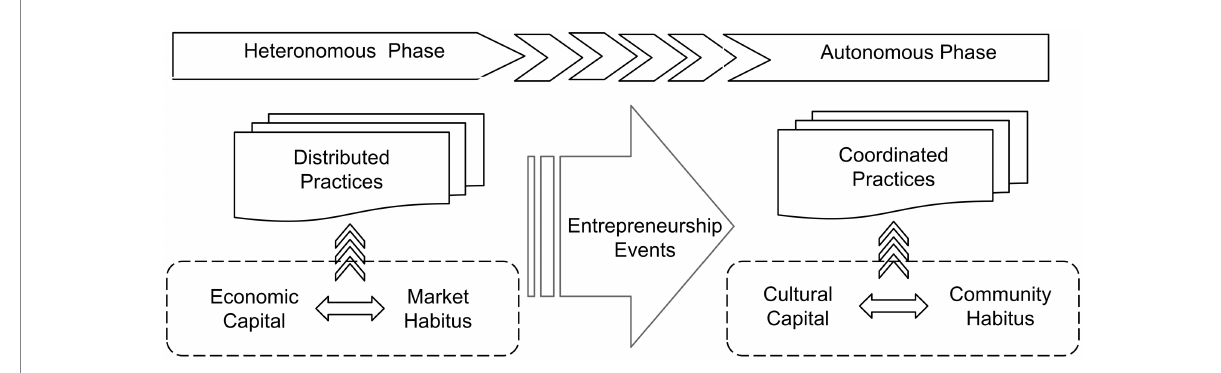
FIGURE 1 Dynamics of an entrepreneurial ecosystem: a two-phase